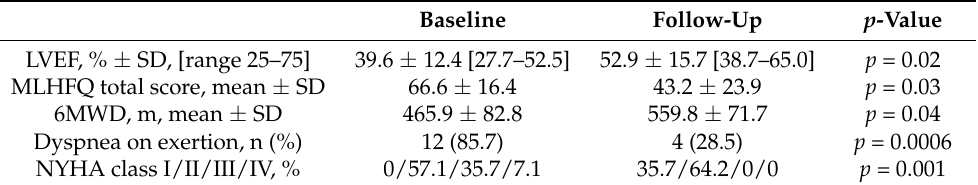
Table 2. Course of clinical symptoms at baseline and at follow-up upon treatment in responders.